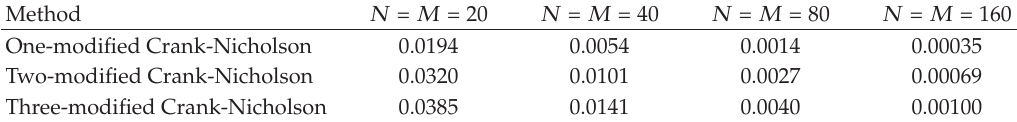
Table 2: Relative errors for the approximate solution of problem (cid:3) 5.1 (cid:4)